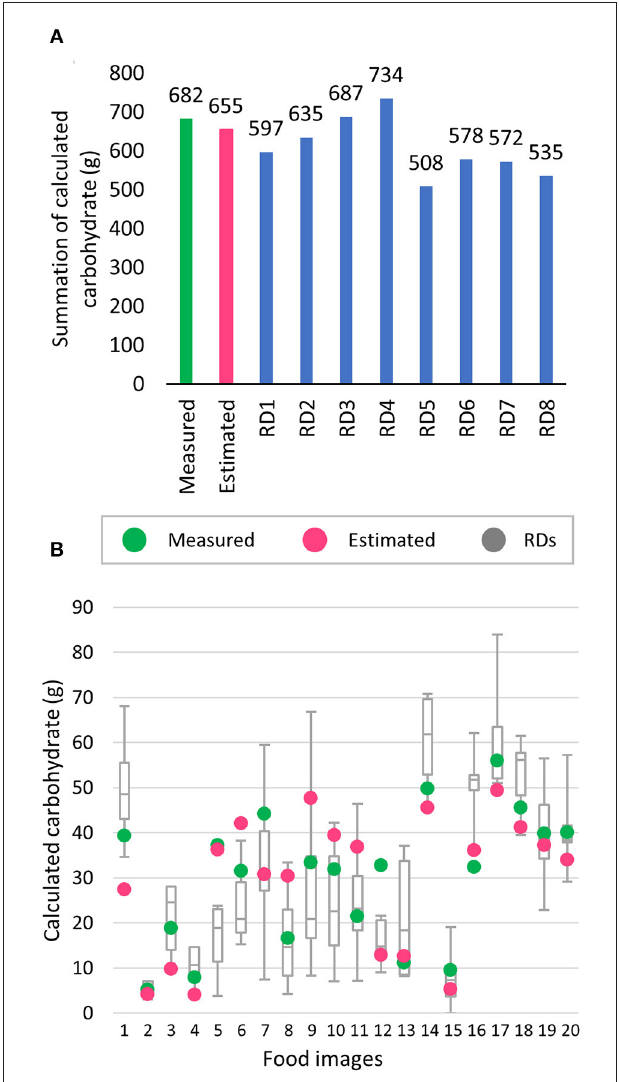
FIGURE 5 | Comparison of calculated carbohydrate between measured weight (green), estimated weight (pink), and estimated results from eight registered dietitians (RDs); (A) Summation of carbohydrates; (B) scatter plot of calculated carbohydrate of each image for Measured (green), Estimated (pink), and box and whisker plot represent the estimation results from eight RDs.